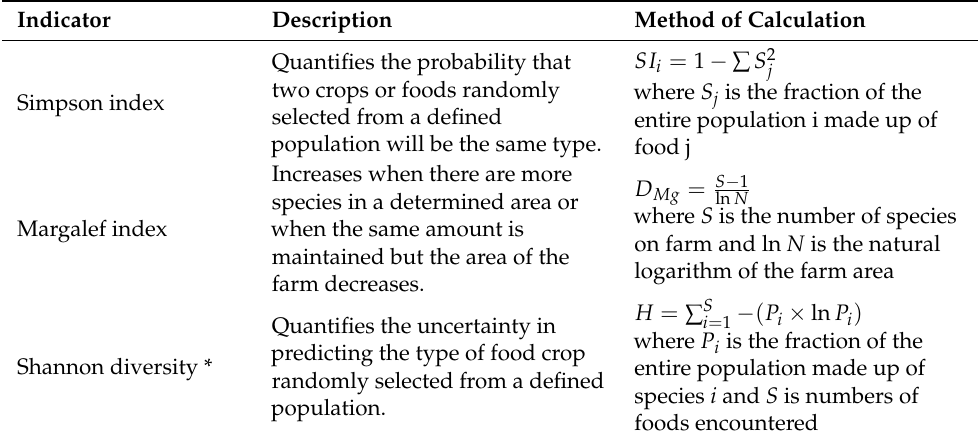
Table 2. Summary of the use of indicators of agricultural production diversity and of market access and/or